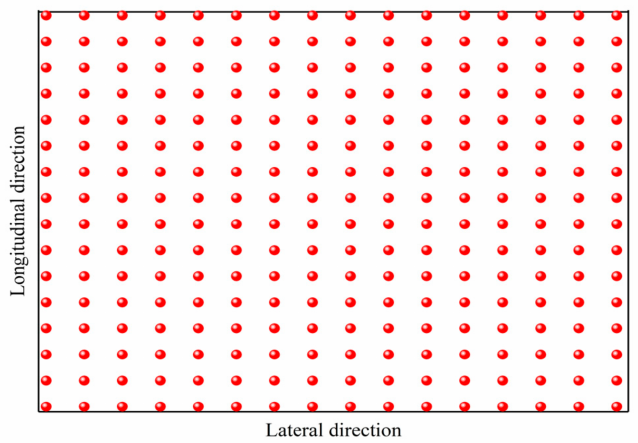
Figure 2. Data acquisition principle of the three-dimensional optical